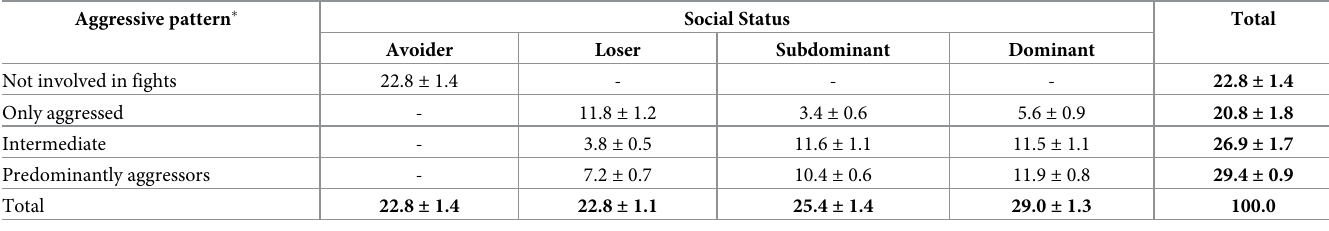
Table 1. Proportion of sows exhibiting each aggressive pattern � according to the social